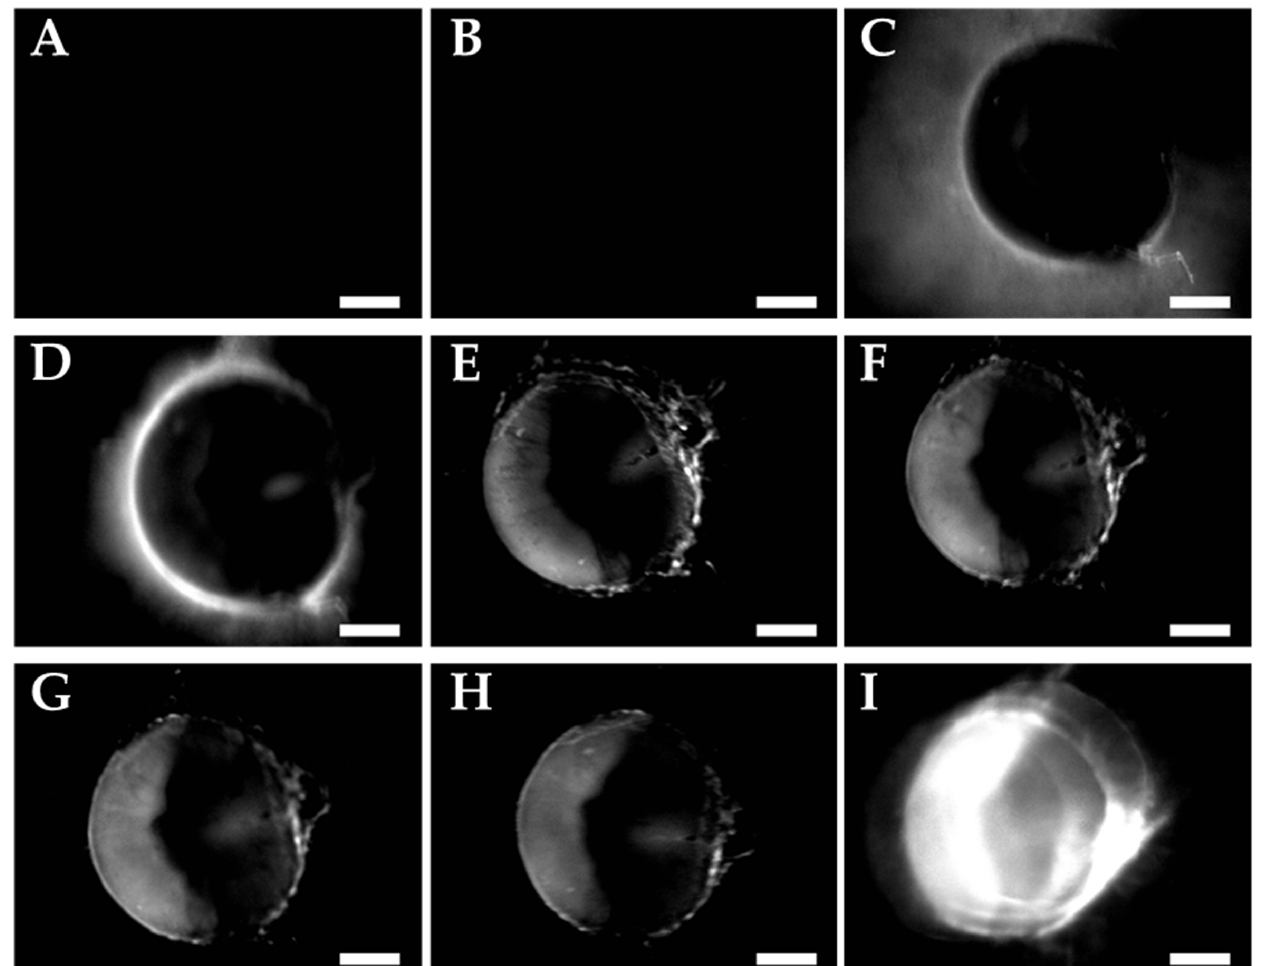
Figure 5. Fluorescence emission images of A549 nodules incubated with uPA-cPPP 4/52 (30 µL in NaCl 0.9% at 0.8 mM of Pha eq ) ( A ) before injection, ( B ) 5 min, ( C ) 1 h, ( D ) 2 h, ( E ) 3 h, ( F ) 4 h, ( G ) 5 h, ( H ) 6 h and ( I ) 23 h after injection. Scale bar of 500 µm.